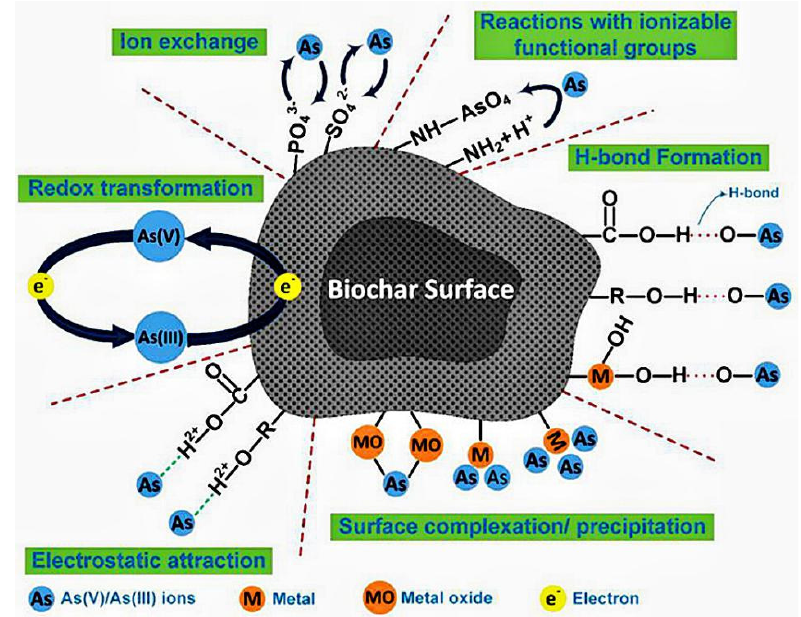
Figure 27. Principal removal mechanisms of As from water by modified biochar [81]. Reprinted with permission from KhaledZoroufchi Benis et al. (2020). Copyright 2020, Elsevier.